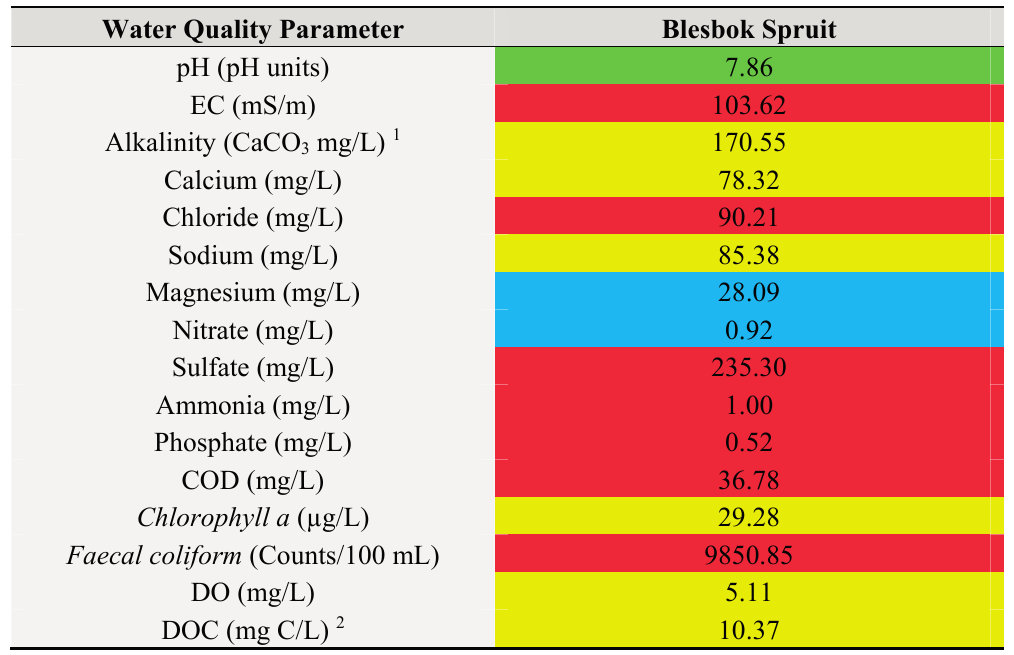
Table 2. The average concentration of the selected significant water quality parameters for the Blesbok Spruit catchment as well as their compliance to set water quality standards and